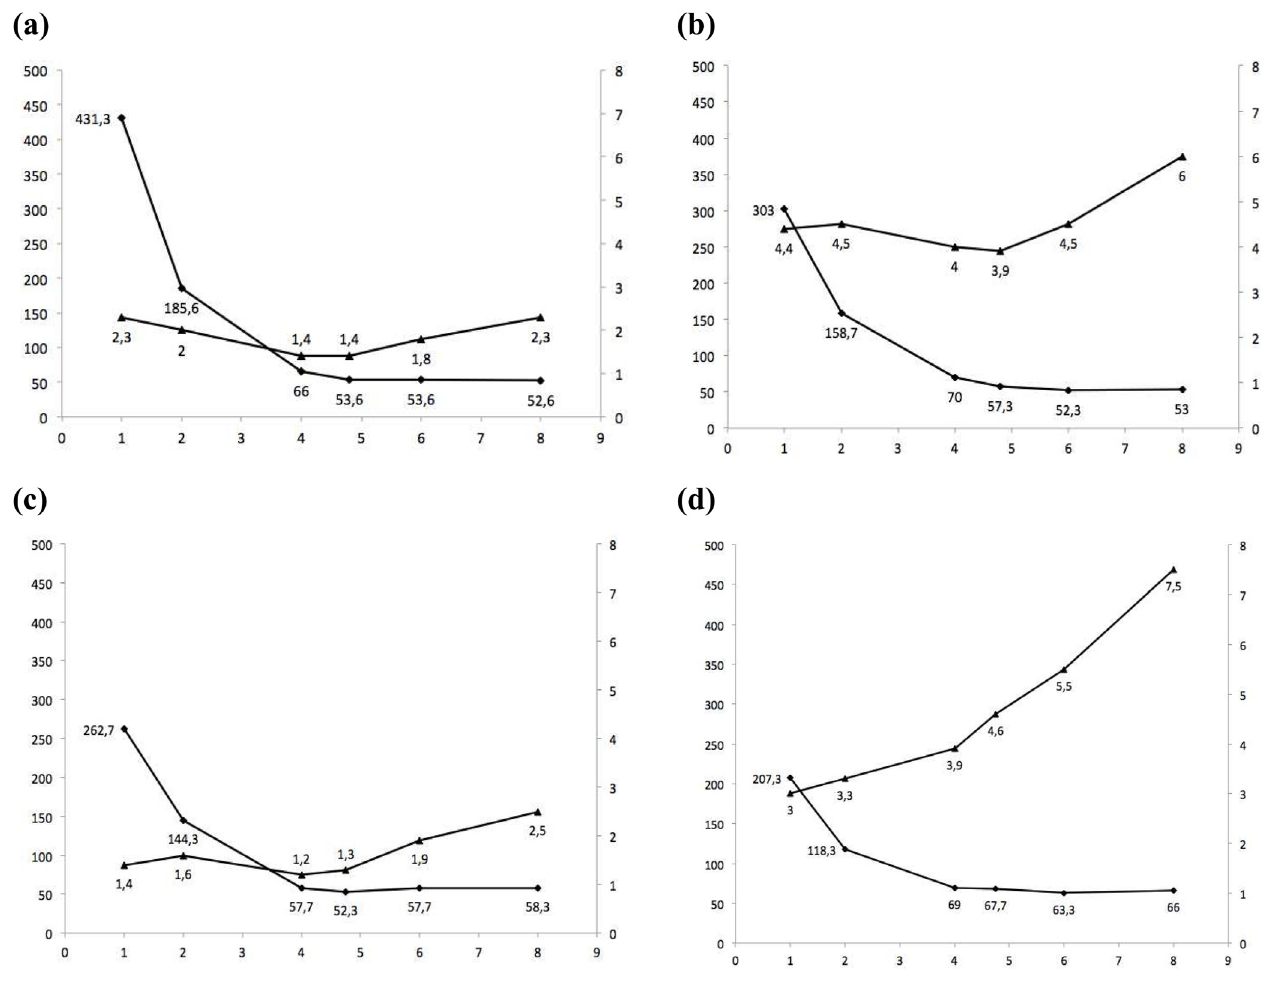
Figure 2. Time to reach 1 MAC and the calculated AA consumption for each fresh gas flows. ( a ) Flow-i /sevoflurane. ( b ) Flow-i / desflurane. ( c ) Aisys /sevoflurane. ( d ) Aisys/desflurane. Time(s) is on the Y-axis. FGF (l/min) is on the X-axis. AA (ml) is on the secondary